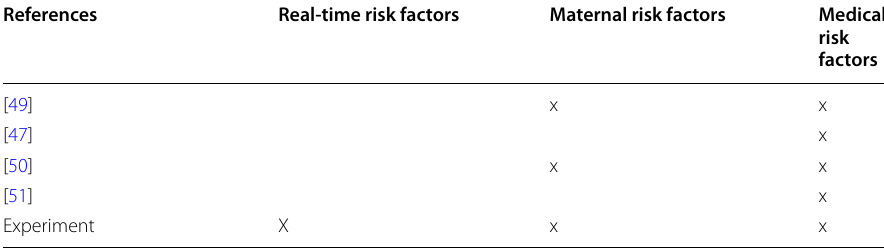
Fig. 11 Silhouette method value for k Table 10 External Clustering Validation: Comparison with previous studies